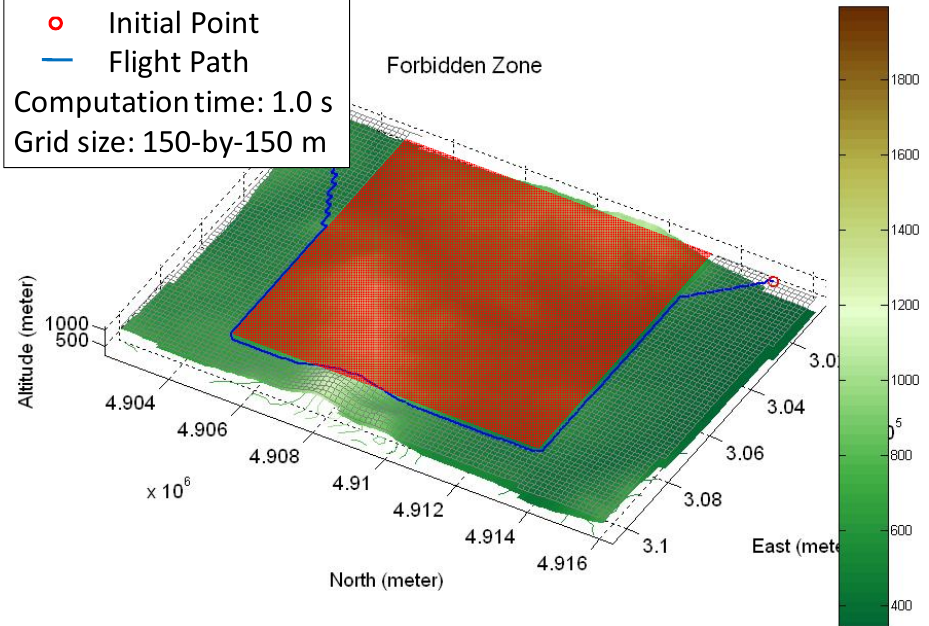
Figure 6. The red area is the forbidden zone on the virtual flight map.